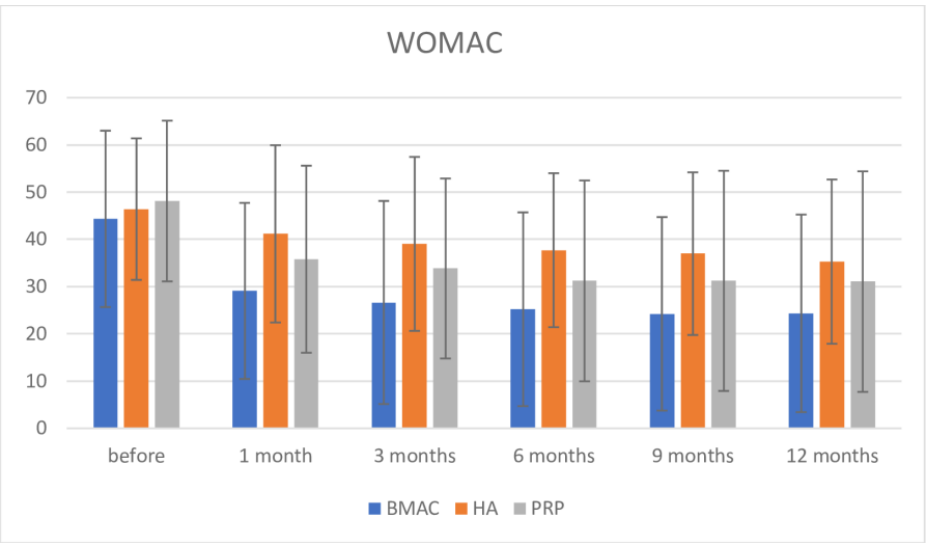
Figure 5. WOMAC scale before intervention and after 1, 3, 6, 9, and 12 months.